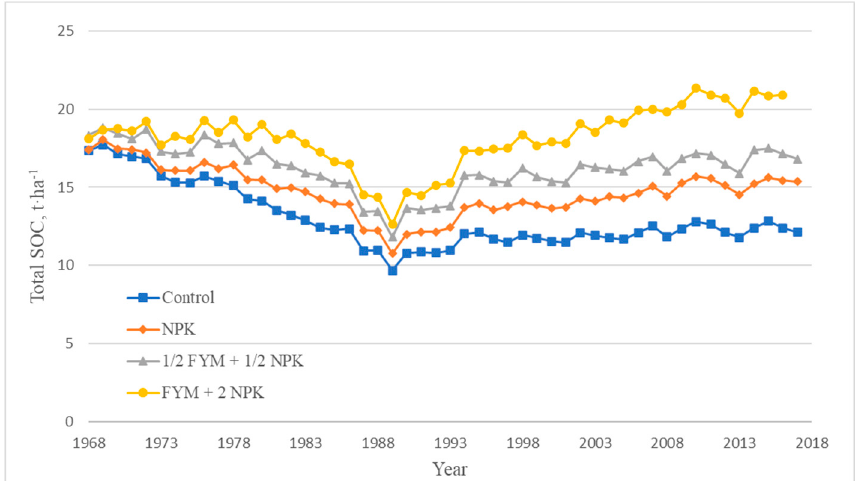
Figure 3. Simulated changes in total organic C stock in the long-term experiment for the period in 1968–2017 based on soil organic carbon (SOC) stock at the end of each calendar year. Over the entire experiment period, the FYM + 2NPK variant resulted in SOC accu- mulation of 3.6 t·ha − 1 (21.3% of the initial content). For the 1/2FYM + 1/2NPK variant, SOC